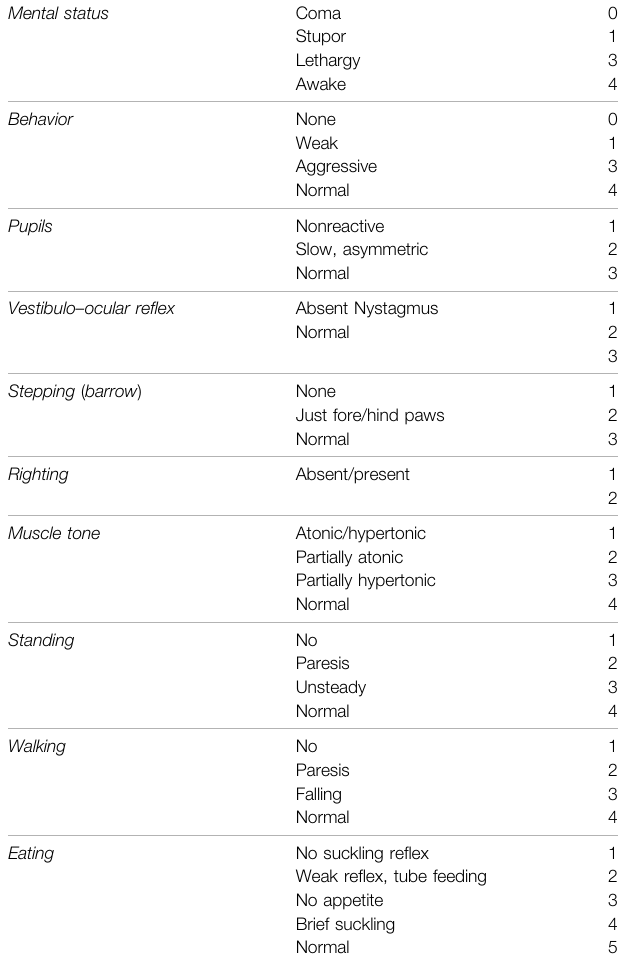
TABLE 1 | Neurobehavioral score